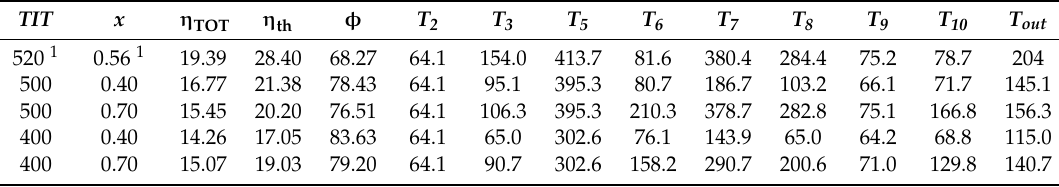
Table 6. Performance metrics and cycle parameters at the optimum and four sub-optimum points for the dual recuperated cycle. All temperatures are in °C.